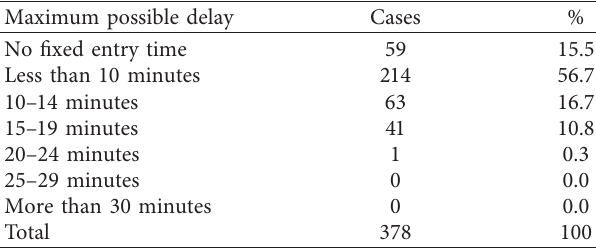
Table 2: Restriction: maximum delay of arrival at workplace without penalty.